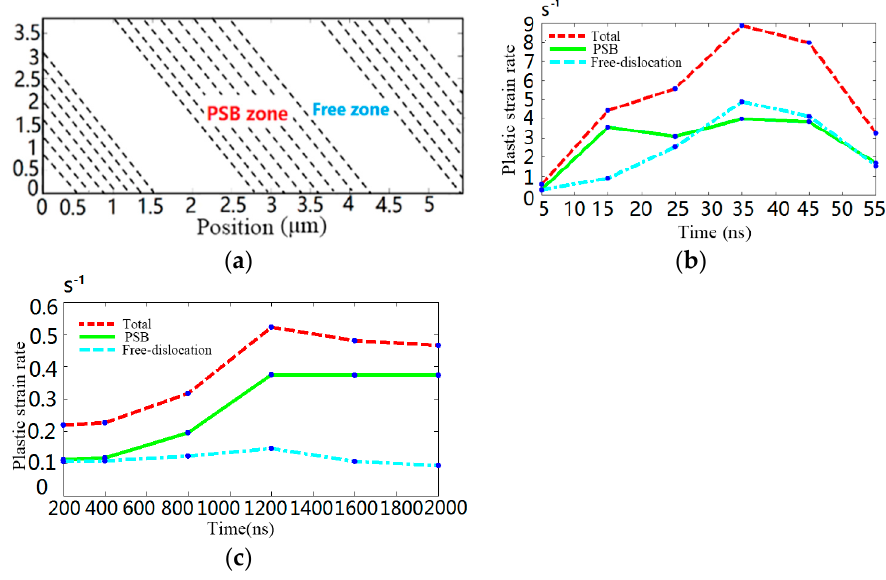
Figure 13. The plastic strain rate evolution of monocrystalline silicon. ( a ) The regional division of monocrystalline silicon; ( b ) monocrystalline silicon strain rate during under transient irregular cutting process; ( c ) monocrystalline silicon strain rate during continuous irregular cutting process.